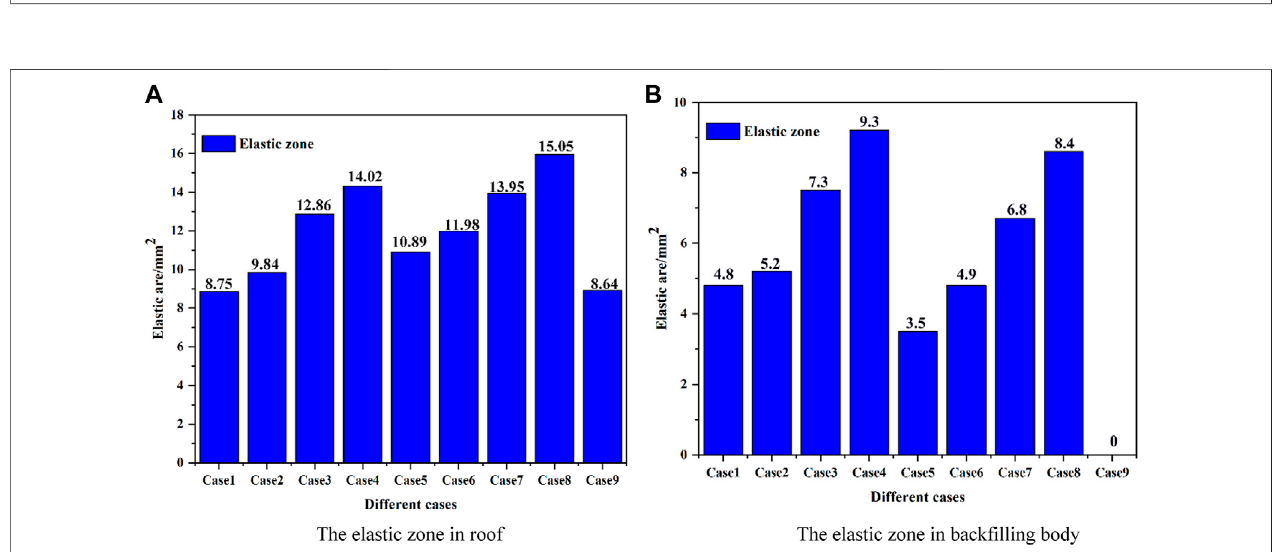
FIGURE 12 | 30 ° (case 1) (B) Fracturing the immediate roof with 45 ° (case 2) (C) Fracturing the immediate roof with 60 ° (case 3) (D) Fracturing the immediate roof with90 ° (case4) (E) Fracturingthemainroofwith30 ° (case5) (F) Fracturingthemainroofwith45 ° (case6) (G) Fracturingthemainroofwith60 ° (case7) (H) Fracturingthe